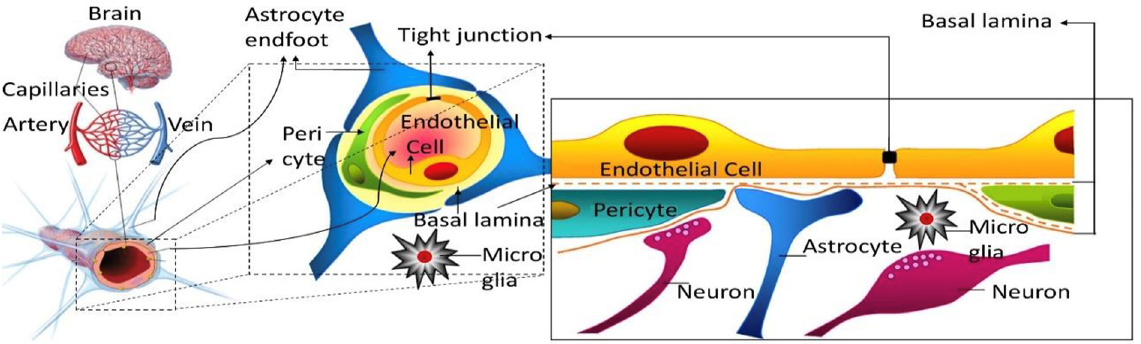
Figure 1. Scheme of the BBB: The endothelial cells of the capillaries are connected by tight junctions and form a physical and biochemical barrier. The pericytes and astrocytes play critical roles in the induction and maintenance of the endothelial barrier properties. Microglial cells and neurons also secrete signals, which can influence the endothelial cells. The diameter of the capillaries is on the order of 7–10 µm. Figure adapted from Reference [3] with permission. Copyright 2010, Elsevier. The purpose of the PK models covers a range from the evaluation and the fitting of sets of experi- mental data that are as good as possible to simulations and predictions based on few or no experi- mental data, to employing complex physiologically based pharmacokinetic (PBPK) models with pa- rameter values obtained from in silico, in vitro, and in vivo studies. Which model is appropriate also depends on the experimental design in each case and the physicochemical characteristics of the agent to be evaluated. Macromolecules differ greatly in kinetic behavior from small molecule drugs